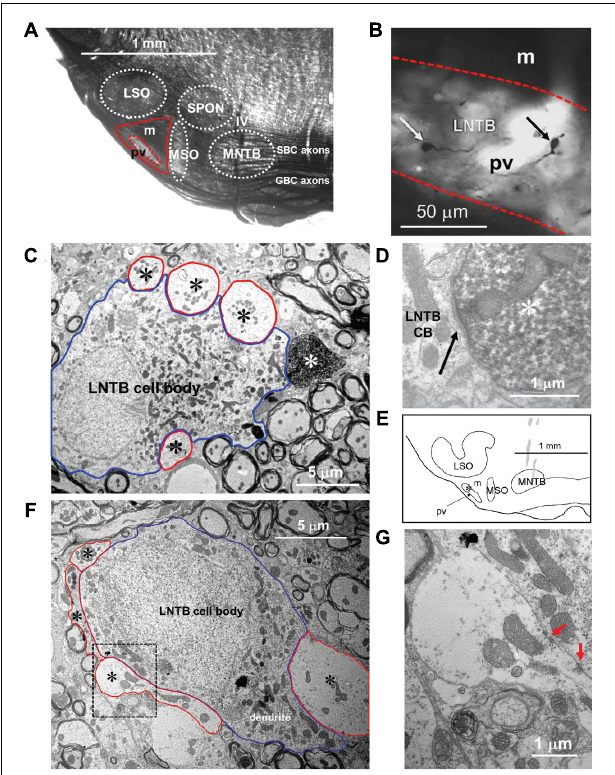
FIGURE 2 | Macroscopic and microscopic identification of pvLNTB. (A) Plastic-embedded coronal section of gerbil brainstem showing the location of the main nuclei (white dotted outlines) embedded within the large bundle of axons known as the TB arising primarily from globular and spherical bushy cells in the cochlear nucleus. The area lateral to the MSO and ventral to the LSO (red solid line) is designated the LNTB. The area enclosed by the dotted red line is referred to as pvLNTB while the remaining dorsal, darker area is mLNTB. (B) Swellings (arrows) of labeled GBC axons within the pvLNTB (pv; red dotted lines). m: mLNTB (C) Electron micrograph of one of the labeled swellings (white asterisk) shown in B confirming that it is a synaptic terminal synapsing on a cell body in pvLNTB (blue outline) adjacent to other large unlabeled terminals (red outlines, black asterisks). (D) Synaptic specialization (arrow) of the labeled terminal in C. (E) Location of one of our physiologically characterized, labeled neurons (asterisk) in pvLNTB (outline). (F) Electron micrograph of the labeled pvLNTB cell body (blue outline) whose location is shown in E. Red outlines and asterisks show the large unlabeled synaptic terminals ending on this cell. (G) Enlarged view of the area outlined by a black dotted line in F showing synaptic specializations (red arrows).